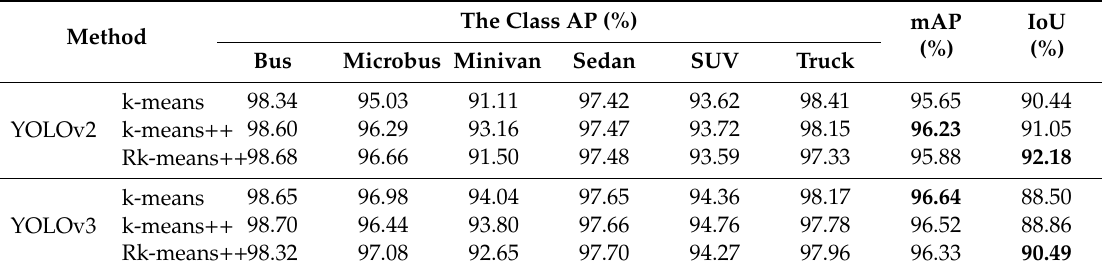
Table 2. Experimental results on comparing different anchor box generation methods.